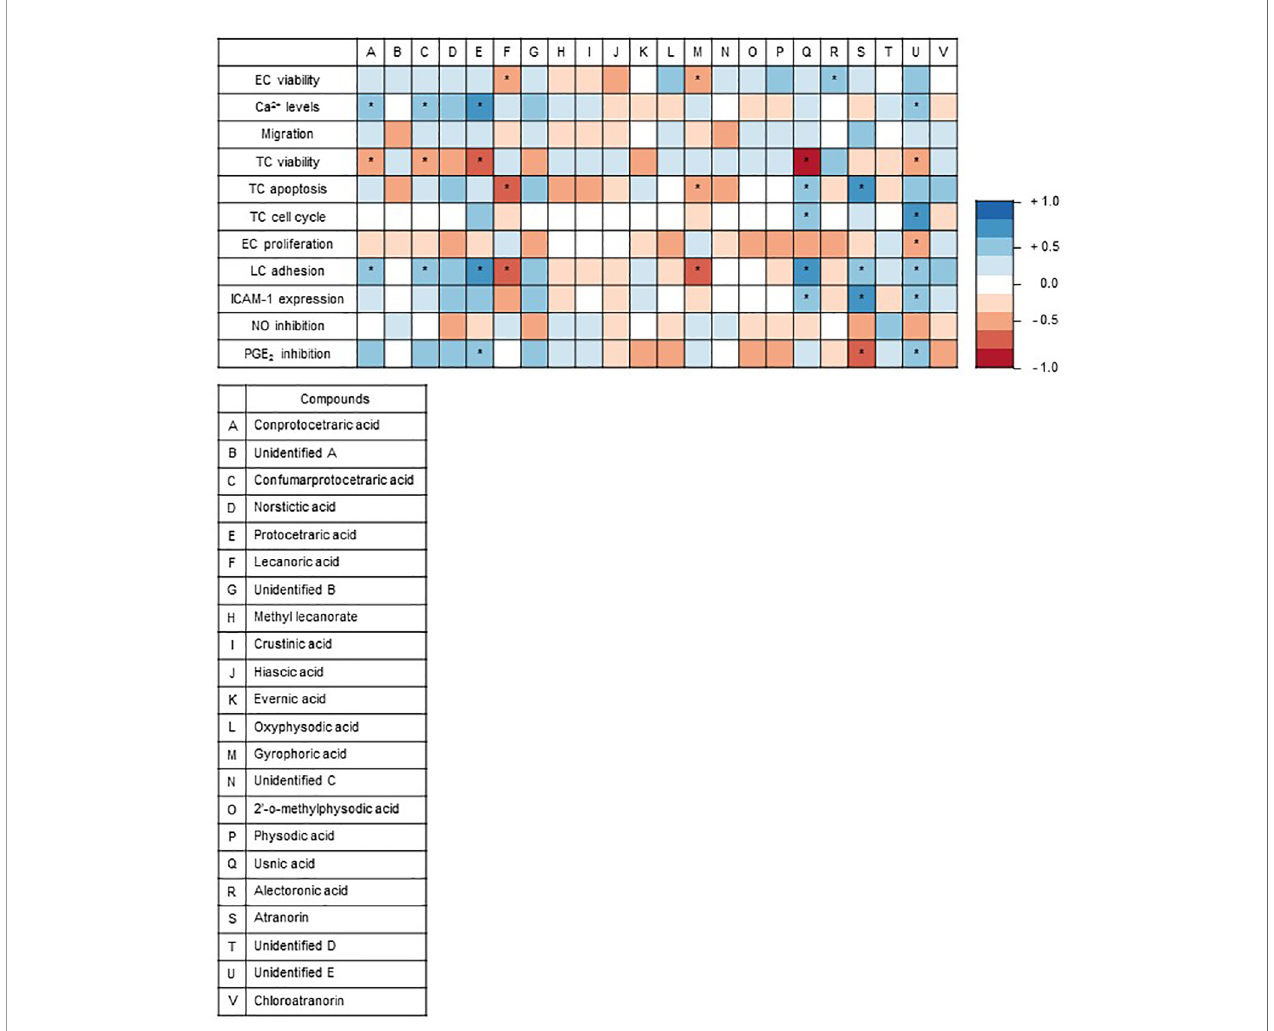
FIGURE 5 | Graphical representation of Spearman ’ s correlation matrix. The natural compounds detected via high performance liquid chromatography (HPLC) in the lichen extracts were correlated with the outcomes of the 11 functional and biochemical test systems. The heat map shows Spearman ’ s correlation between the outcomes of the test systems and the natural compounds of the lichens identi fi ed by HPLC. Each column represents an individual compound and each row de fi nes an individual test system. Positive correlation values are in red, and negative correlation values are in blue. The correlation analysis of lichen substances and assay outcomes was conducted with R (V3.6.1 available online https://www.R-project.org/) (Macdonald et al., 1999) and visualized as correlation matrix (V0.84 available online https://github.com/taiyun/corrplot; ColorBrewer Palettes V1.1-2 available online https://CRAN.R-project.org/package=RColorBrewer). *p ≤